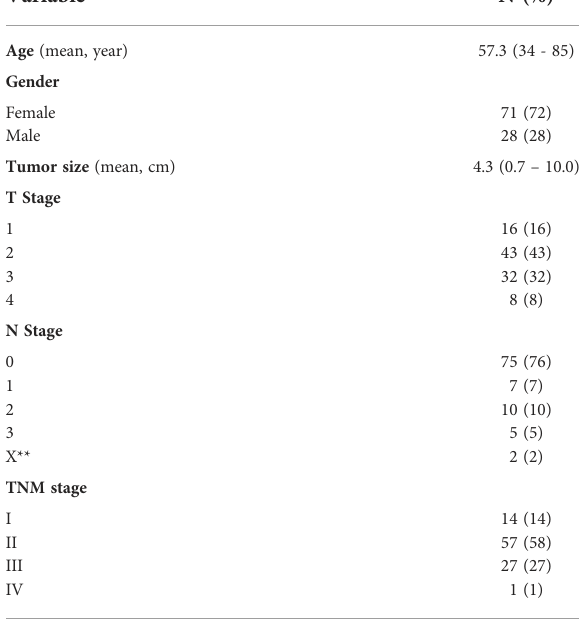
TABLE 1 Patient and tumor